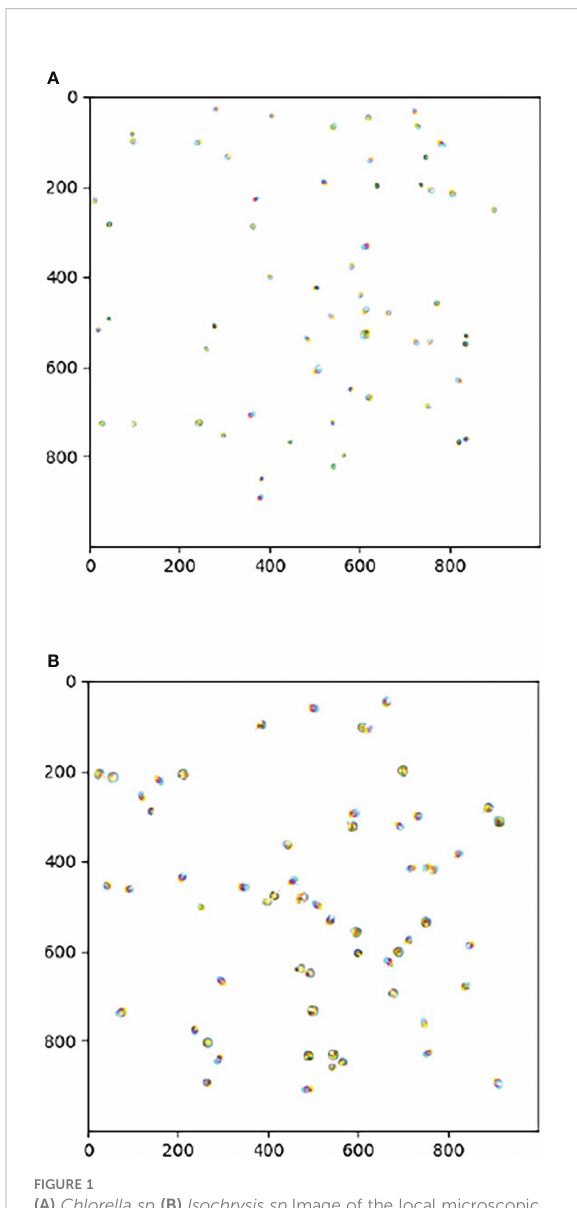
FIGURE 1 (A) Chlorella sp (B) Isochrysis sp. Image of the local microscopic digital